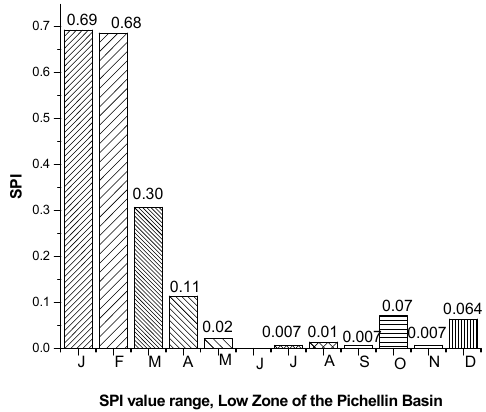
Figure 12. Standardized precipitation index (SPI), middle zone.